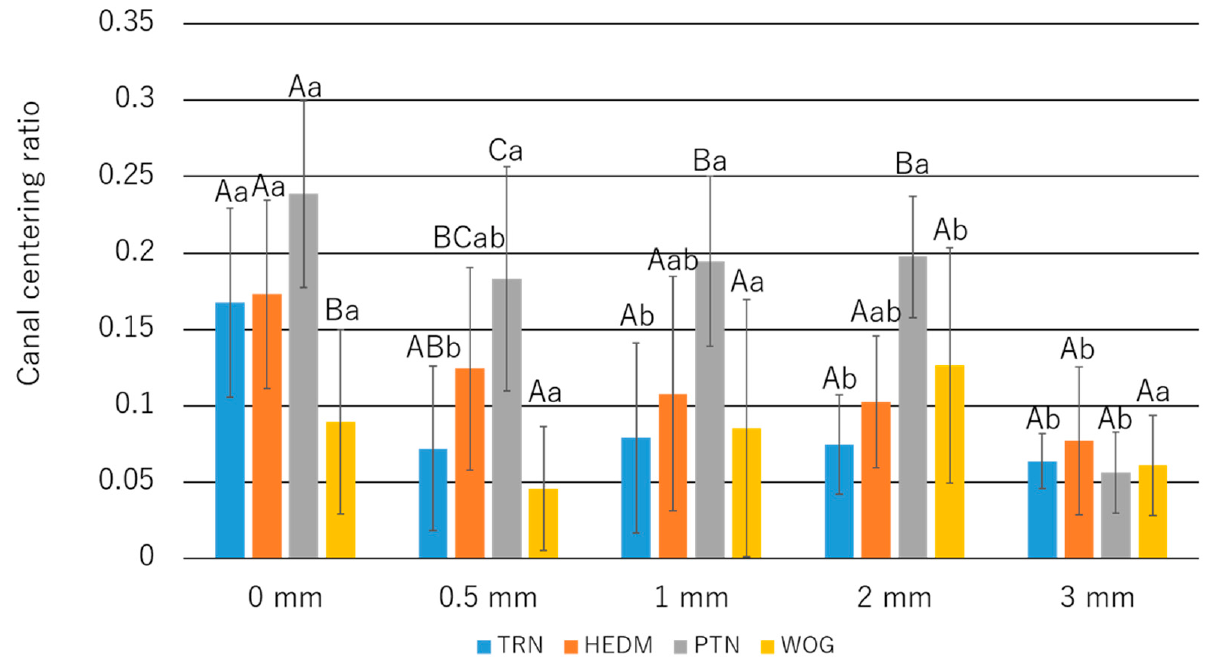
Figure 7. Canal centering ratios. Values are means and standard deviations (n = 10). Different uppercase letters in the measurement level indicate that the values are significantly different in intergroup comparisons ( p < 0.05; two-way ANOVA and Tukey test). Different lowercase letters indicate that the values are significantly different within the same instrument ( p < 0.05; two-way ANOVA and Tukey test).